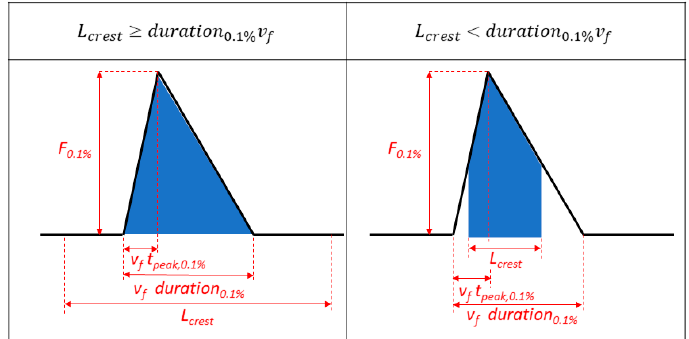
Figure 18. Possible situations when calculating AF 0.1% .